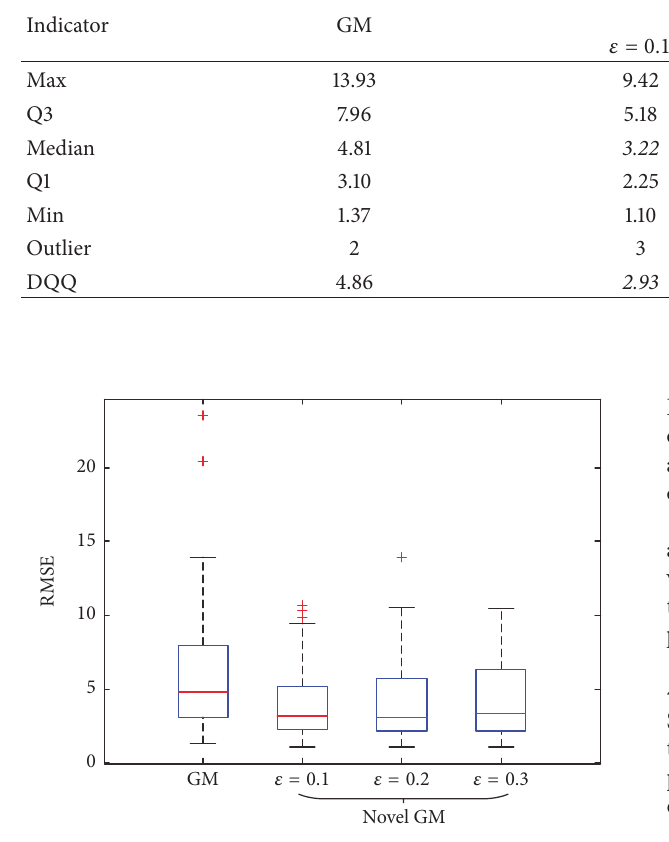
Figure 11: Box plot of RMSEs at different values of 𝜀 in the novel GM and GM.